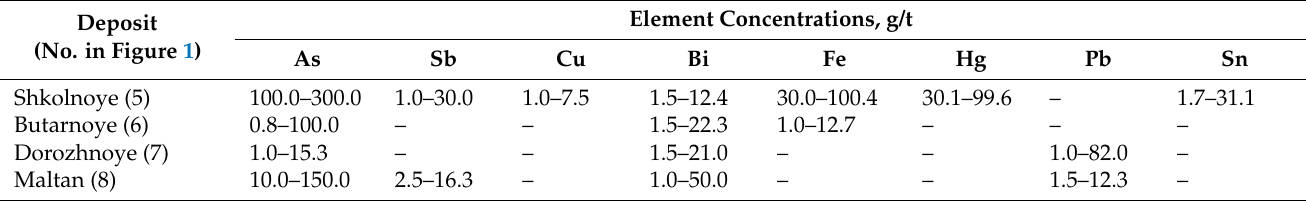
Table 2. Concentration of microimpurities in native gold from ores of gold–quartz veins GIT deposits.